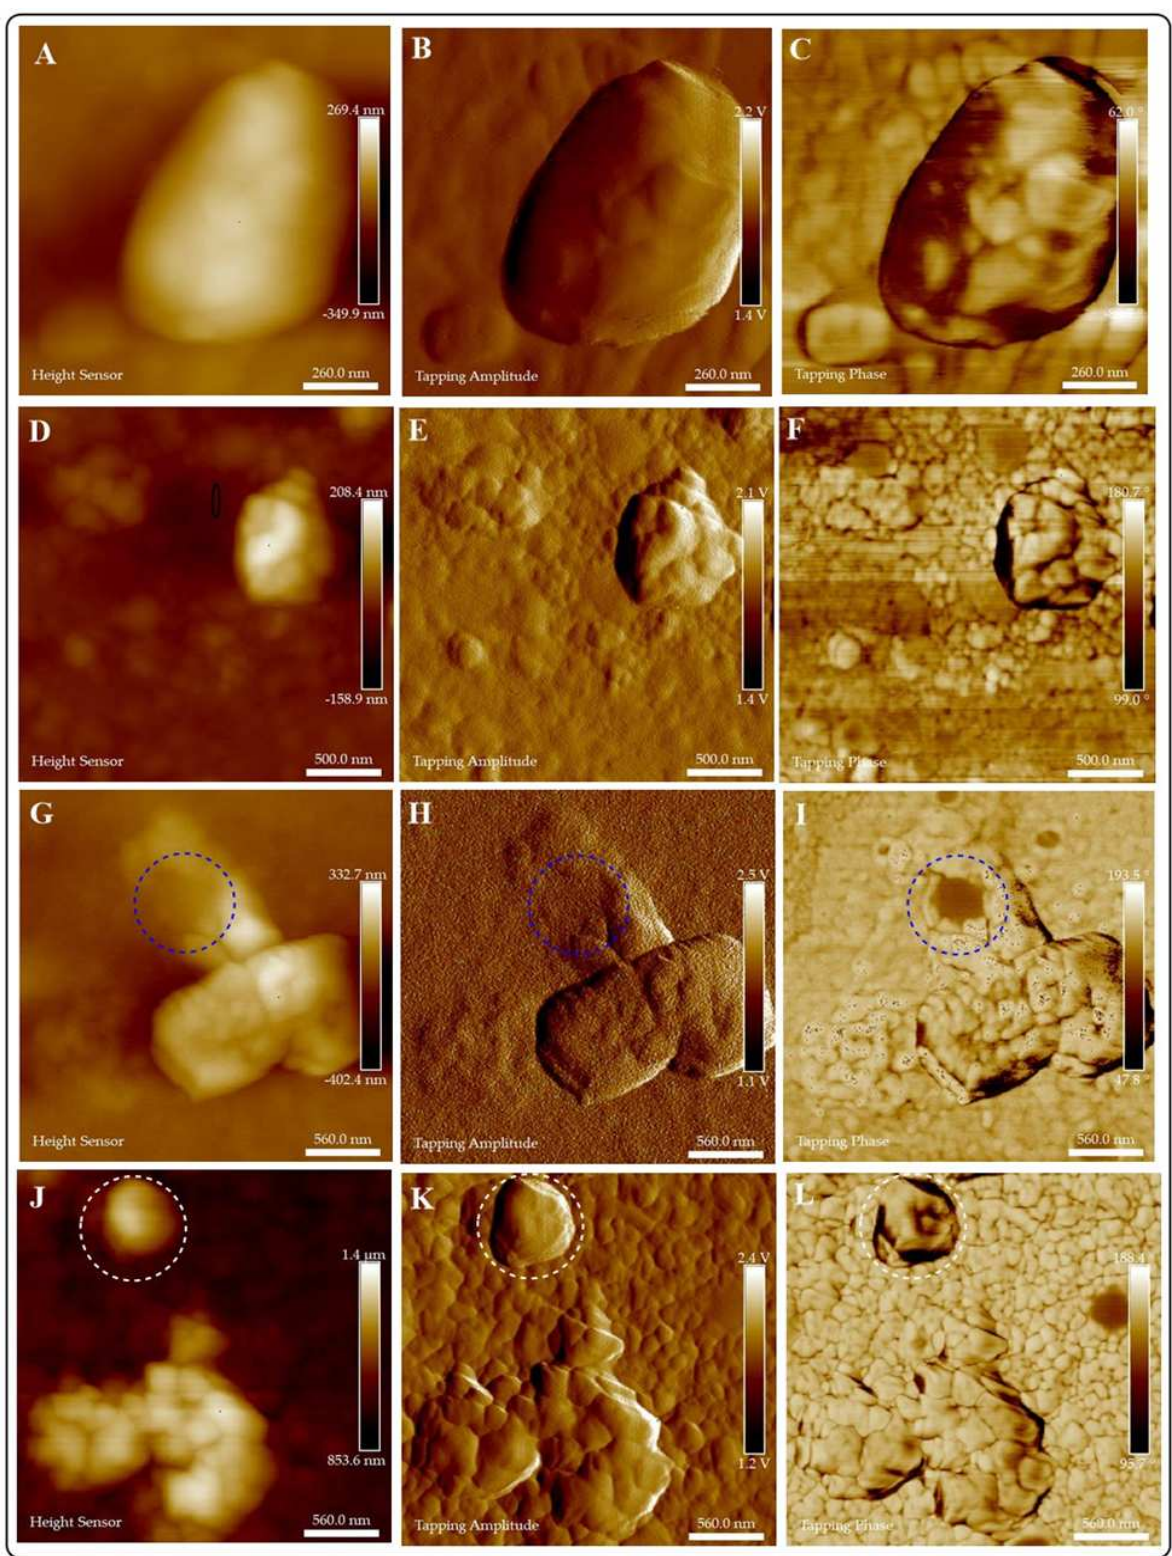
Figure 10. Evaluation of the exposition of S. schenckii to different doses of CuI@Ch for 1 h. Height, amplitude and phase images are presented for: Control group ( A – C ), and S. schenckii exposed to different doses of CuI@Ch: 75 µ g/mL ( D – F ); 100 µ g/mL ( G – I ); 125 µ g/mL ( J – L ). Blue dotted circles indicate the penetration of the material on the fungal cell and exposition of its components. White dotted circles indicate morphological changes in S. schenckii due to the almost complete fungal cell coverage of the